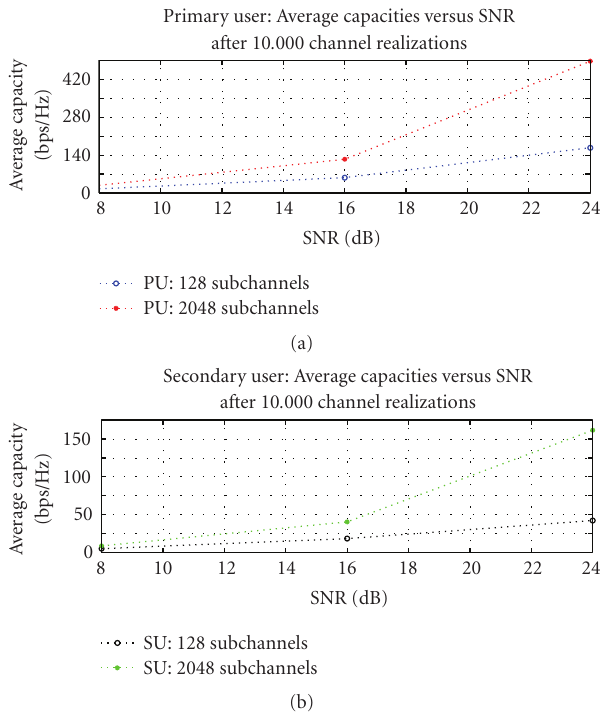
Figure 7: Average Capacities comparison for 128 and 2048 sub- channels (primary/secondary user), SNR = 8dB, 16 dB, and 24